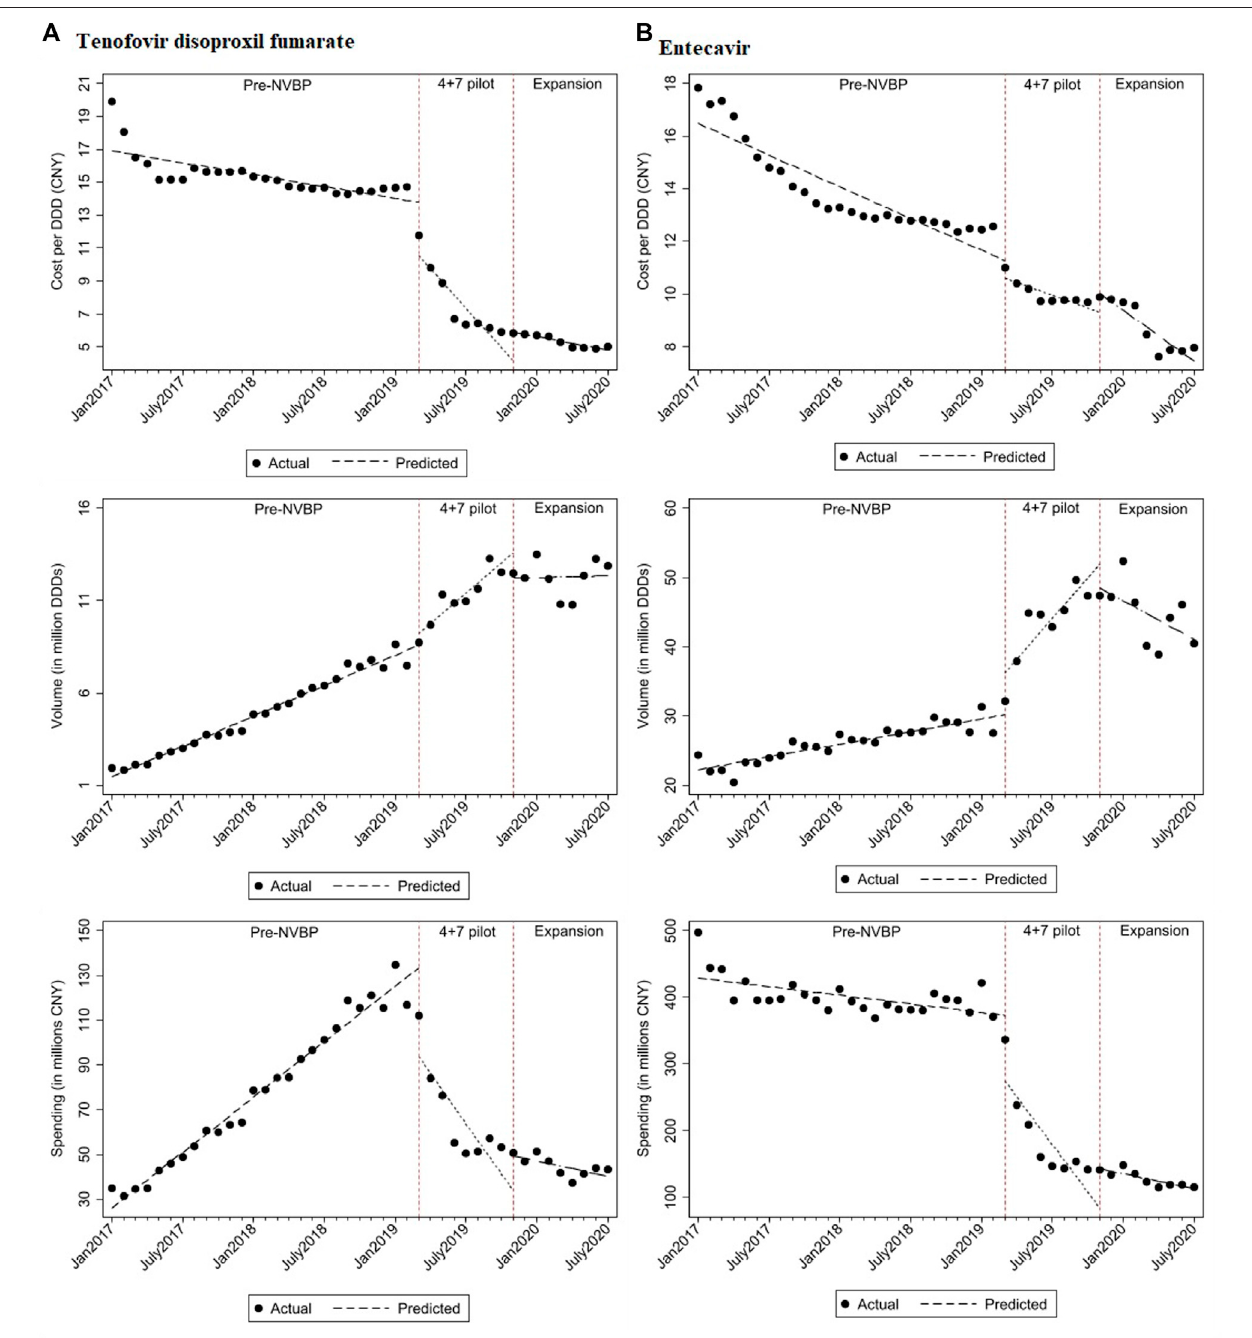
FIGURE 1 | The observed and predicted (A) TDF and (B) entecavir from aggregated ITS analysis*. * The predicted values were obtained from aggregated ITS analysis for TDF and entecavir procured in "4+7 ” cities.